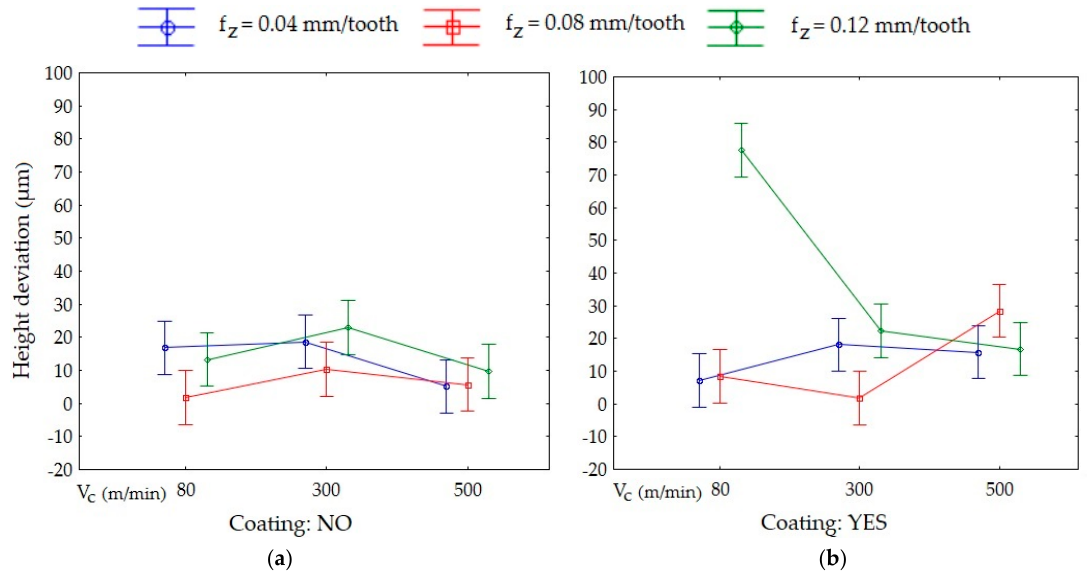
Figure 7. Interaction on height deviation using: ( a ) non-coated tool and ( b ) TiAlN-coated tool. The vertical bar of one group (V c = 80 m/min, f z = 0.12 mm/tooth, coating: YES) did not overlap